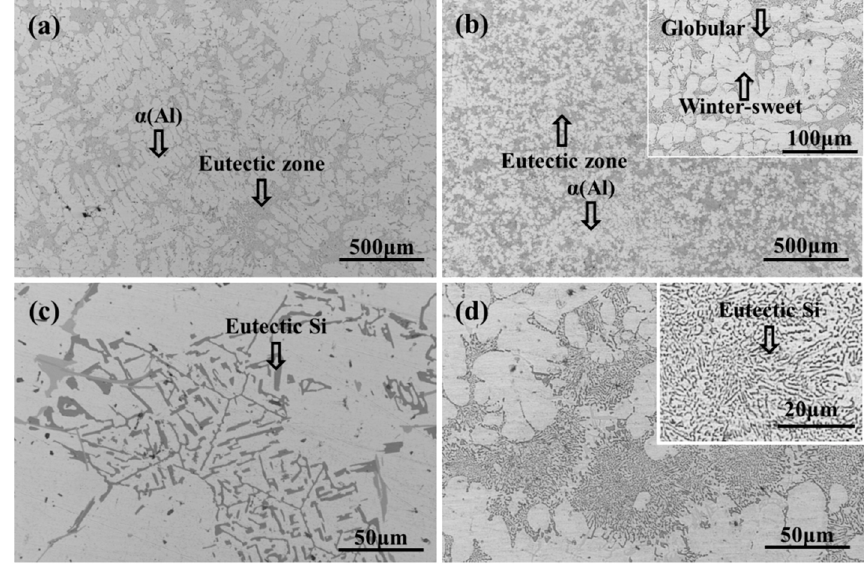
Figure 2. Microstructure of alloy formed by di ff erent casting methods: ( a ) and ( c ) alloy formed by gravity casting, ( b ) and ( d ) eutectic Si formed by squeezing casting.